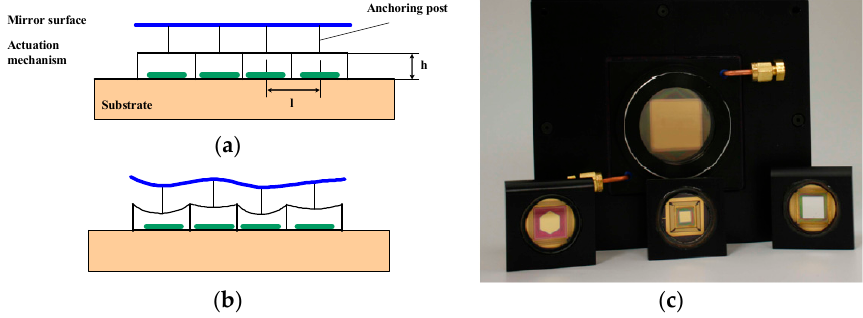
Figure 2. Continuous membrane Micro-Deformable Mirrors (MDM) from Boston Micromachines Corporation (BMC): schematic view of the ( a ) MDM non-actuated, ( b ) MDM actuated; ( c ) devices picture (courtesy from BMC).